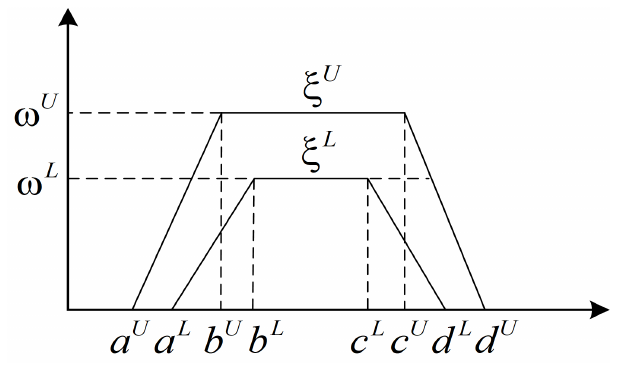
Figure 2. Interval-value fuzzy